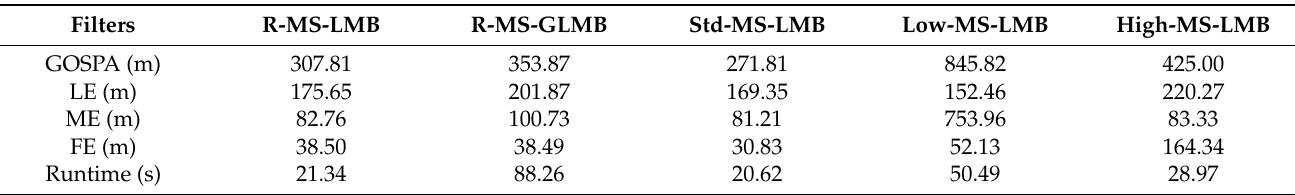
Figure 9. Comparisons of GOSPA metric, LE, ME, and FE errors. Table 2. Time average GOSPA and the average runtime.